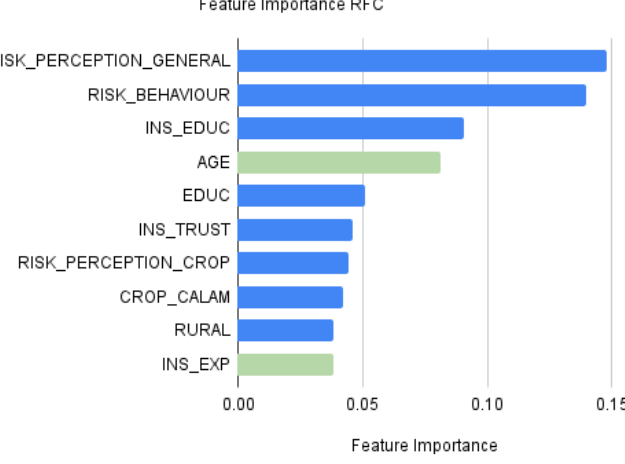
Figure 1. Feature Importance: RFC.